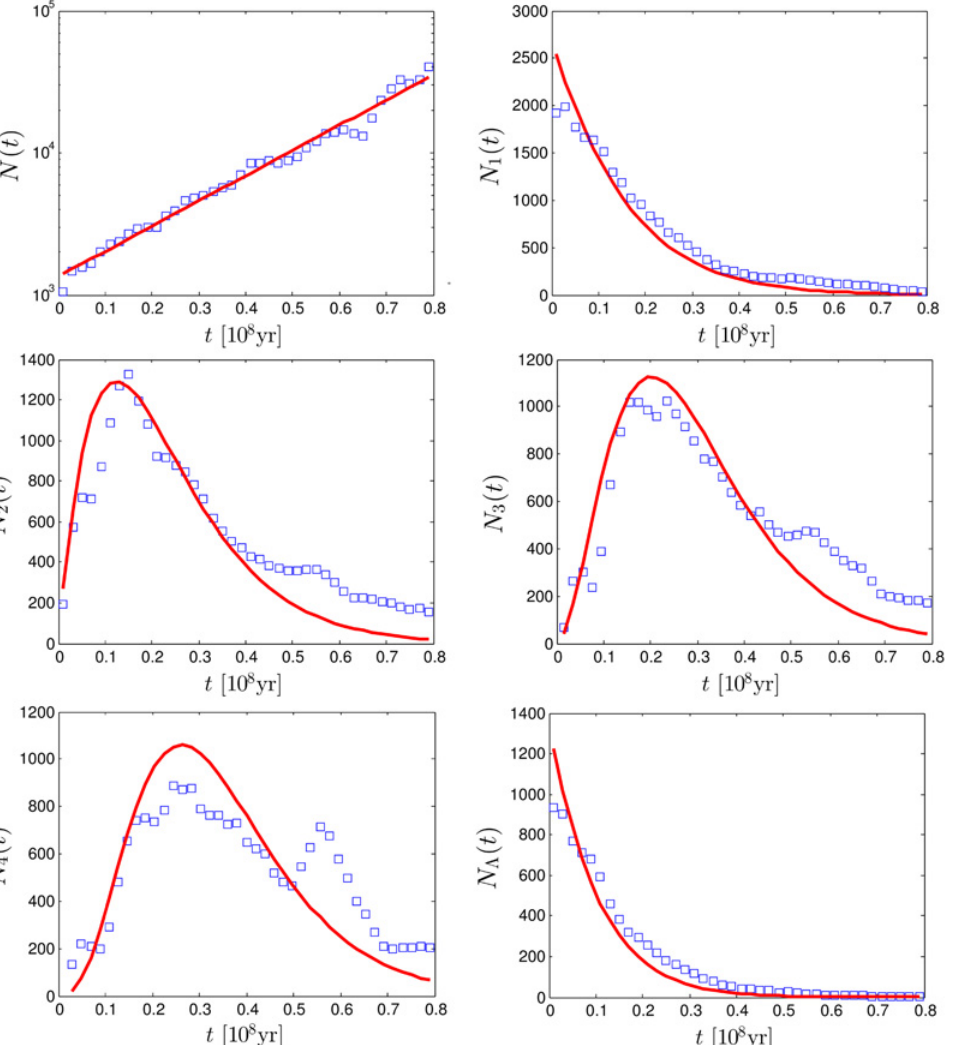
Fig 6. Comparison of analytic predictions to the pairwise distances data of Tyrannidae family with M = 460 species taken from the database [28] with t (cid:1) 0.8 × 10 8 Myr. The markers represent the empirical data, while the lines represent the analytic formulas with fitted parameters. (a) Pairwise distance distribution. (b) Minimal distance distribution. (c-e) n -minimal distance distribution. (d) Cherries distance distribution. The fit is performed for all points in the figure with t (cid:1) 0.5 to avoid clear break down of the Yule tree assumptions for larger distances (see text). The lines are based on following set of parameters: λ − μ = 8 × 10 − 8 yr − 1 and λσ = 6.4 × 10 − 8 yr − 1 . For μ = 0, 0.2, 0.4, 0.6, 0.8 × λ this corresponds respectively to σ = 0.8, 0.64, 0.48, 0.32,